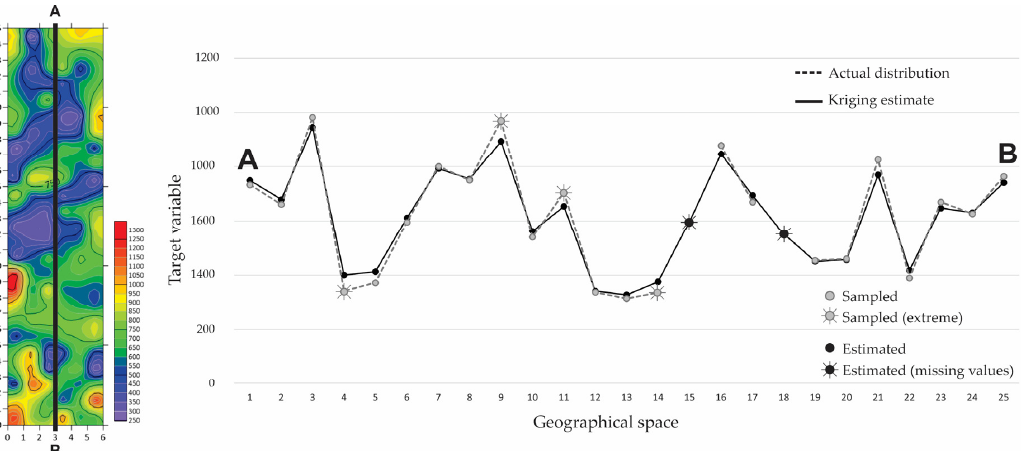
Figure 7. Schematic illustration of the Kriging interpolating approach on how to address missing and extreme values in original experimental data. This is a real data section across plot 1 (section AB) comparing sampled and estimated (via Kriging interpolation) fresh weight (FW) values. Kriging calculates values at non-sampled locations (missing values) and applies a correction in case of outliers or extreme values (based on the neighboring data